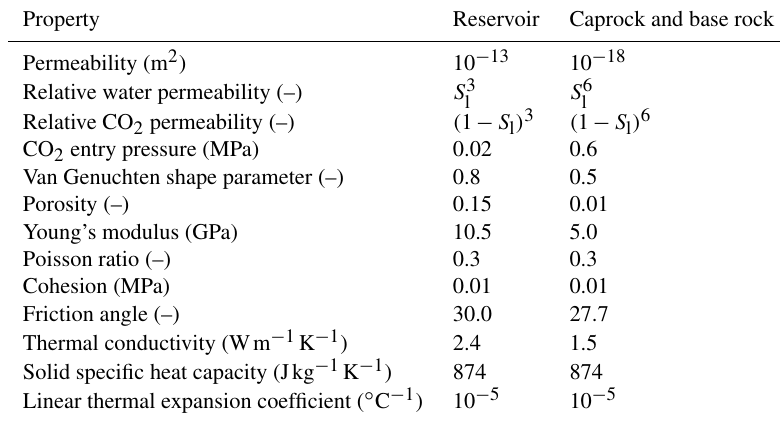
Table A1. Material properties used in the model of cold CO 2 injection shown in Figs. 4 and 5.